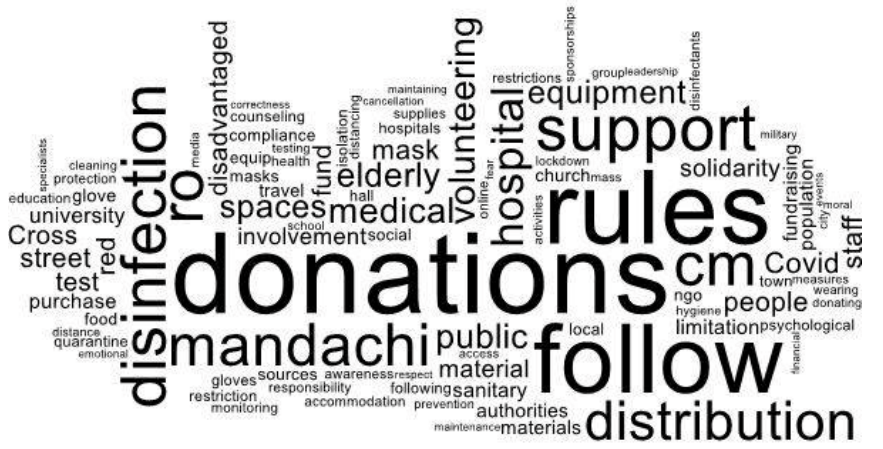
Figure 1. Initiatives of civil society and public actors in the fight against COVID-19 (Source: Survey,